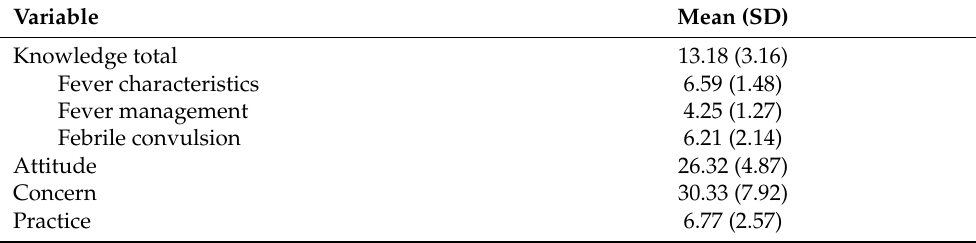
Table 2. Main outcomes regarding febrile convulsion ( n =